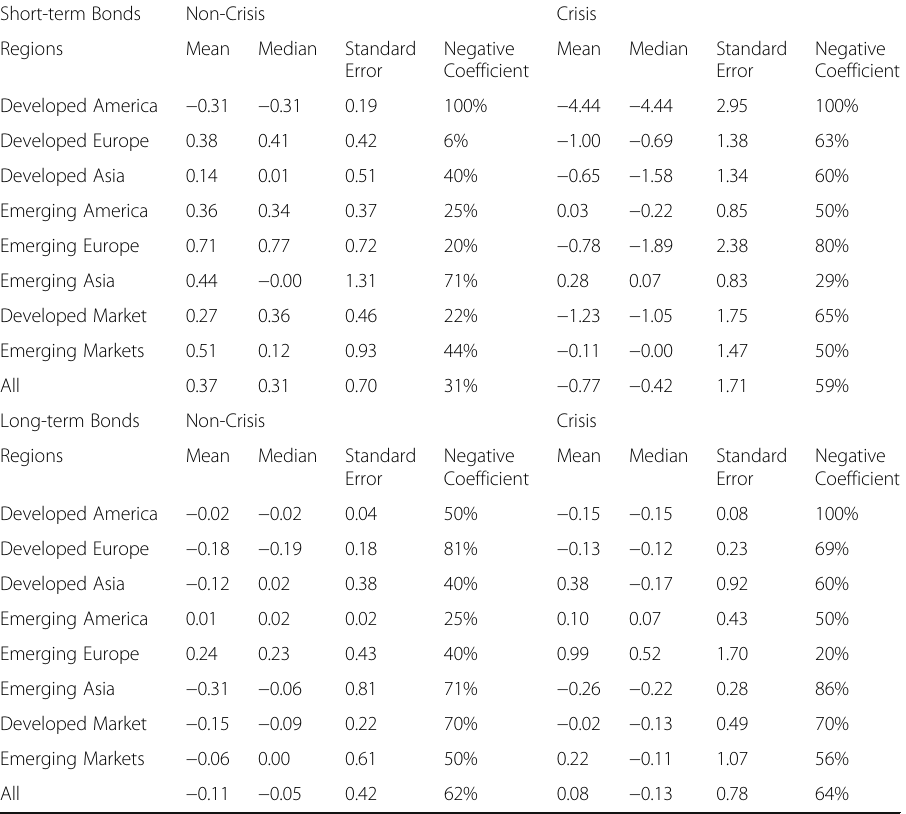
Table 4 Bond coefficients in markov switching